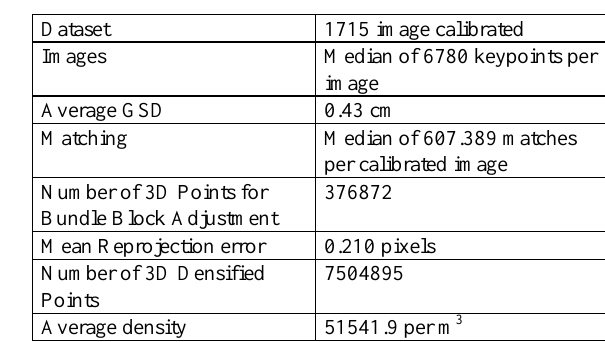
Table 1. Basic characteristics of dataset processing in